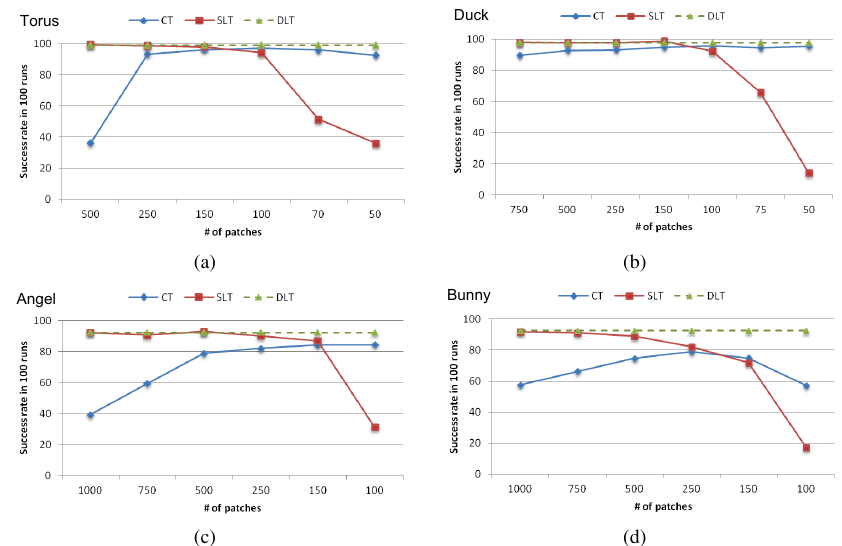
Fig. 14. Results for the success rate in 100 runs of experiment A. The success rate of SLT drastically decreases when the number of patches is reduced, while in CT, a slight or no decrease is noticeable.